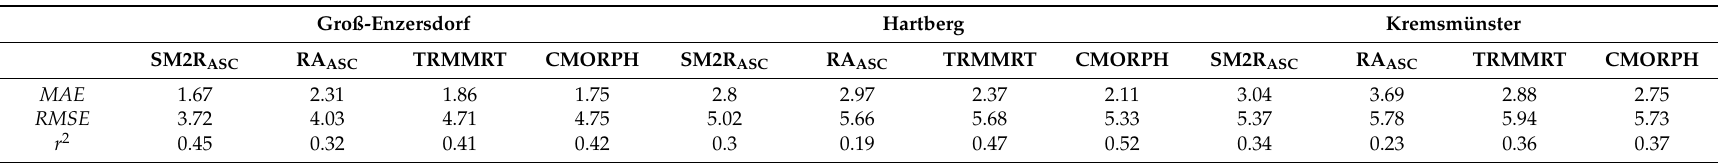
Table 5. Statistical parameters of daily rainfall differences between INCA 23km (benchmark) and SM2R ASC , RA ASC , TRMMRT as well as CMORPH for the months March until July